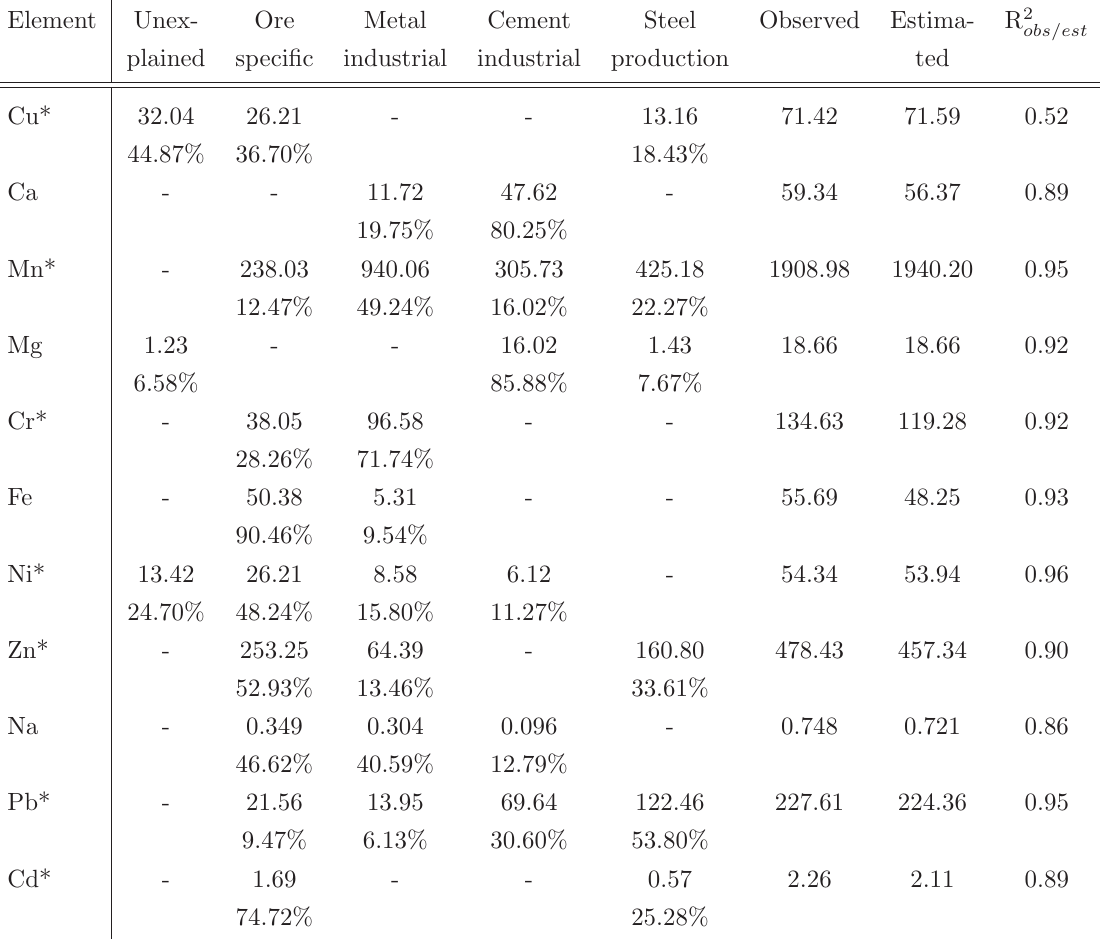
Table 2 Mass apportioning of the analytes with respect to the identified sources (First row is the absolute source contribution, the second row - the relative source